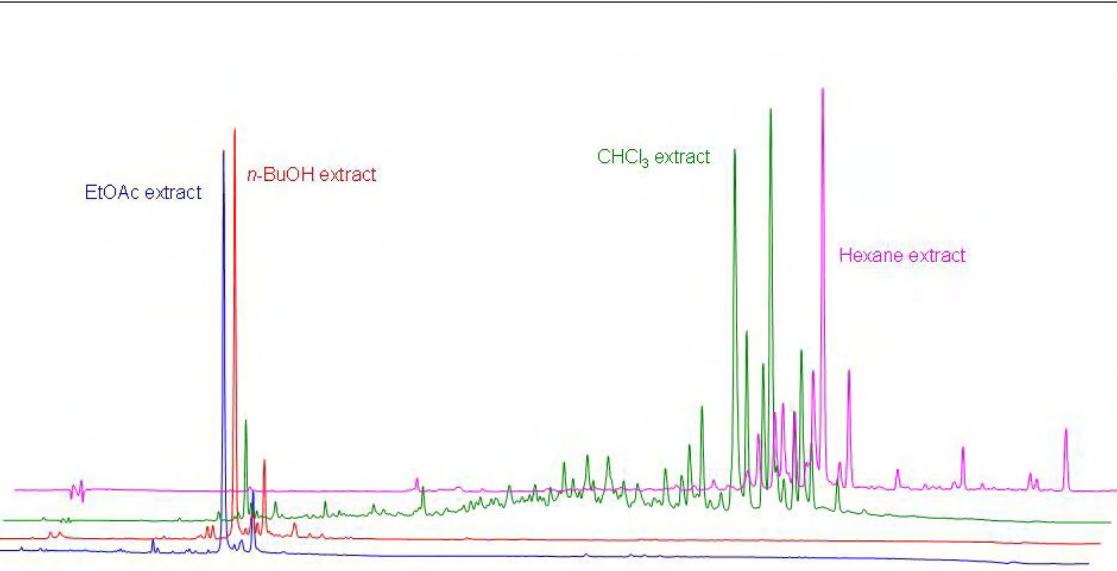
Figure 2 : Comparison of the HPLC chromatograms of the MeOH, EtOAc, n -BuOH, and hexane extracts of P. tomentosa fruits, 1 g L -1 (10 µL